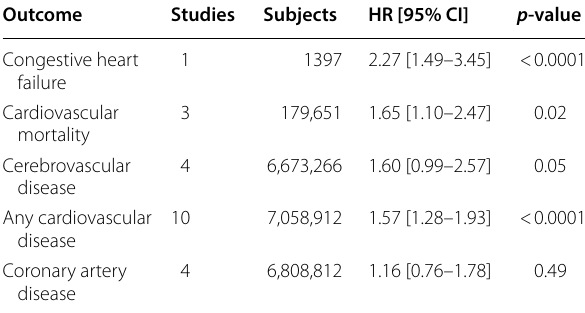
Based on longitudinal studies with 8.4 [range: 1.8–30) years of follow-up. Hazard ratio (HR) is adjusted for six potential confounders; ranked by